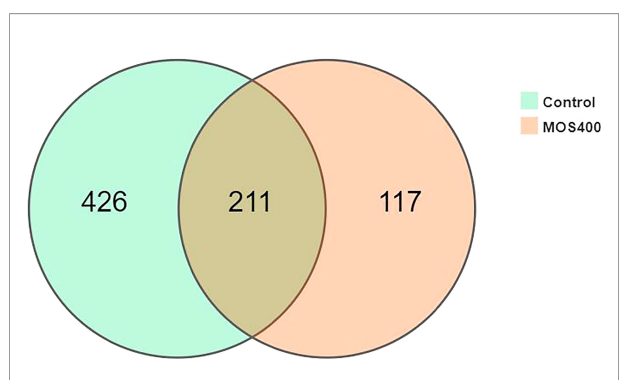
FIGURE 7 | Venn diagram analysis of OTU numbers in the control and